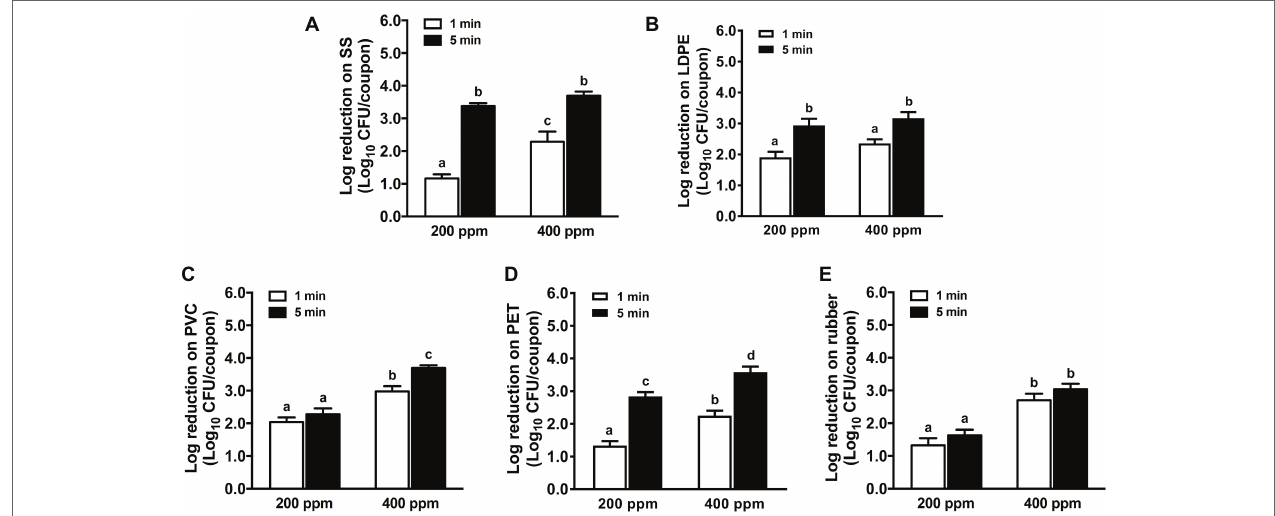
FIGURE 1 | Antimicrobial efficacy of quaternary ammonium compound (QAC) against L. monocytogenes biofilms on food-contact surfaces. (A) Stainless steel (SS); (B) low-density polyethylene (LDPE); (C) polyvinyl chloride (PVC); (D) polyester (PET); (E) rubber. The 7-day-old biofilms on different surface coupons (15 mm × 7.5 mm) were treated with 200 or 400 ppm QAC for 1 or 5 min at 22 ° C. The surviving bacteria were shown as means ± SEMs, n = 3. a–d Bars topped with the different letters are significantly different at p ≤